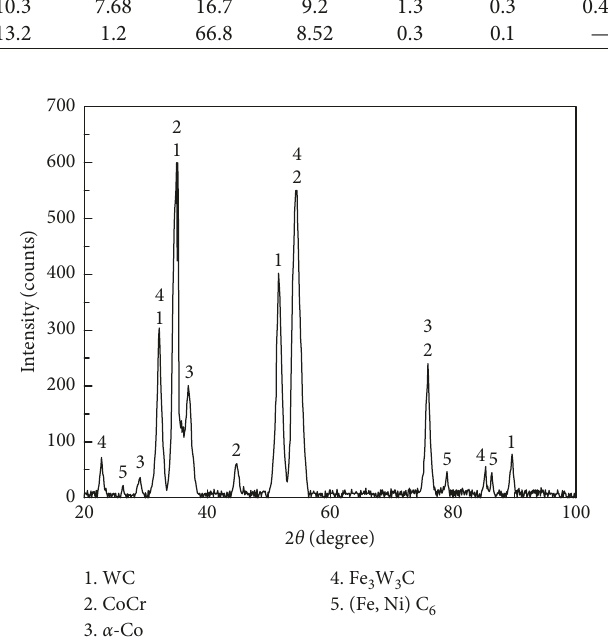
Figure 7: XRD diffraction pattern of the WC-CoCr cladding